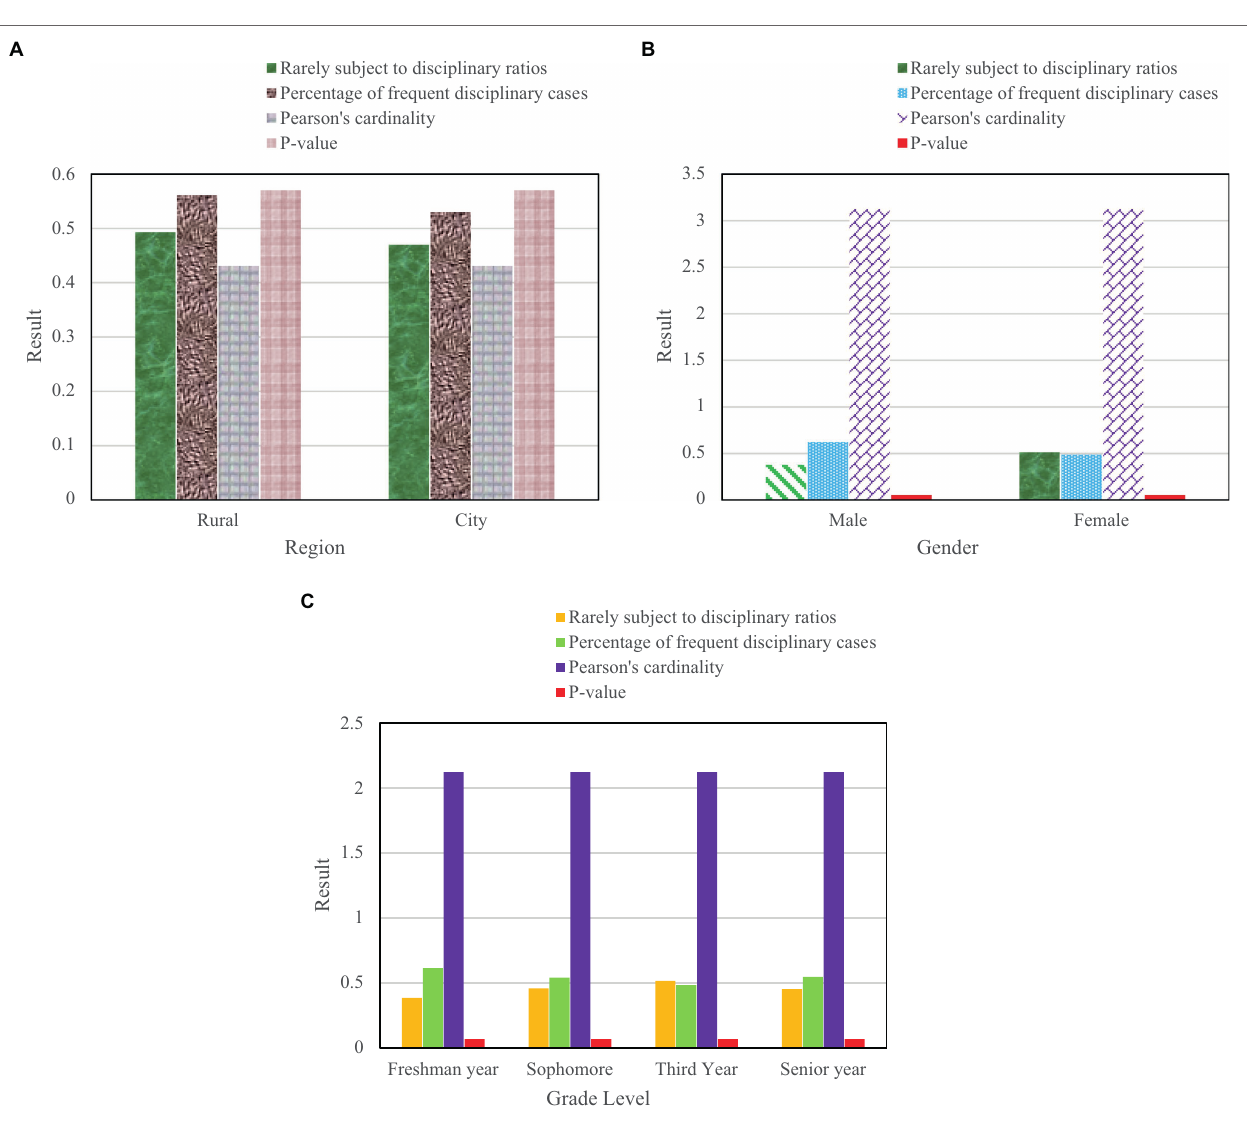
FIGURE 6 | Cardinality test results for teacher discipline on the urban–rural and gender dimensions. [ (A) Test results of geographical dimension, (B) Test Results for Gender Dimension, and (C) Test results of grade dimension].